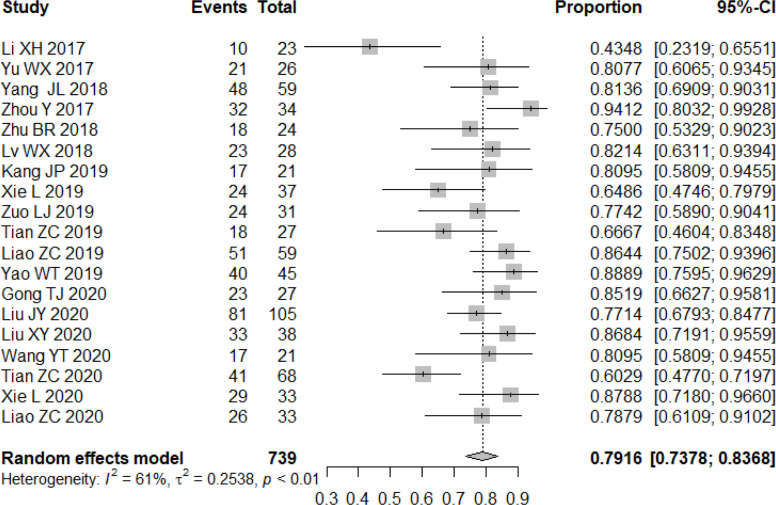
Forest plot showing the DCR of apatinib in the treatment of bone and soft tissue sarcomas.